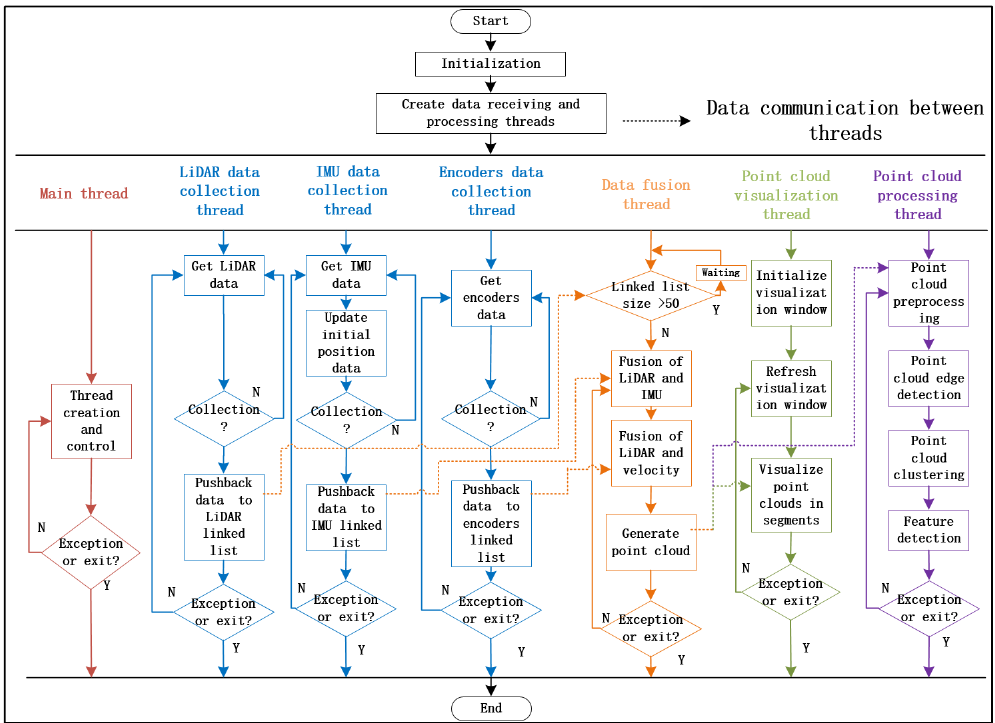
Figure 19. The flowchart of the multi-sensor data fusion algorithm based on multi-thread technology.